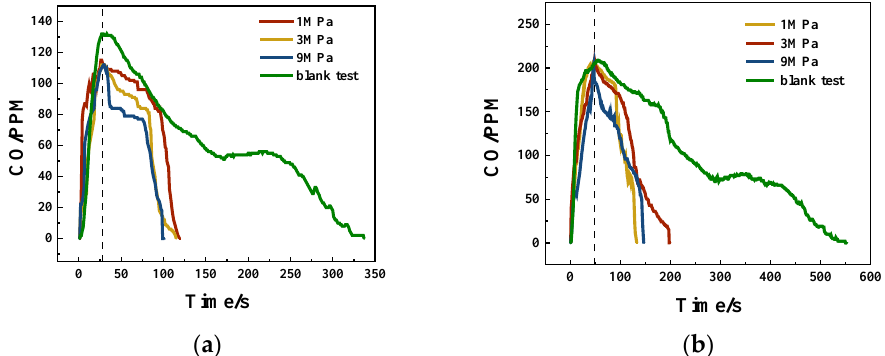
Figure 8. Change curve of CO concentration under different pressures: ( a ) materials are placed horizontally, ( b ) materials are placed vertically.